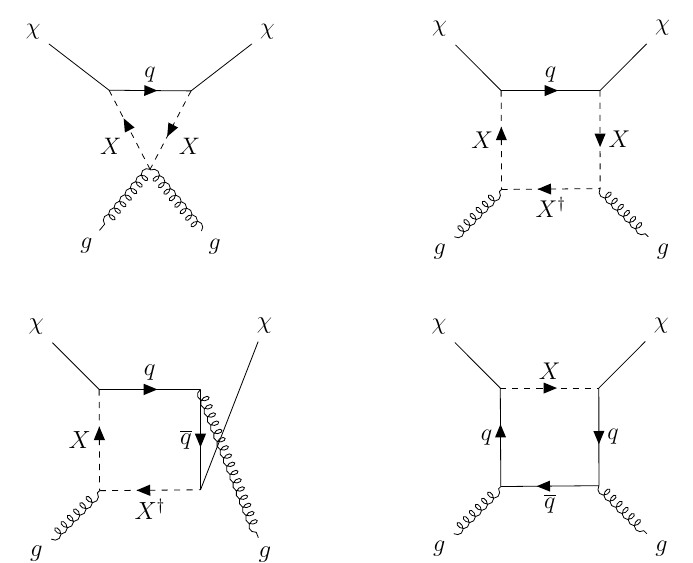
Figure 7. 1-loop diagrams for the DM-gluon elastic scattering, which contribute to the spin- independent DM-nucleon